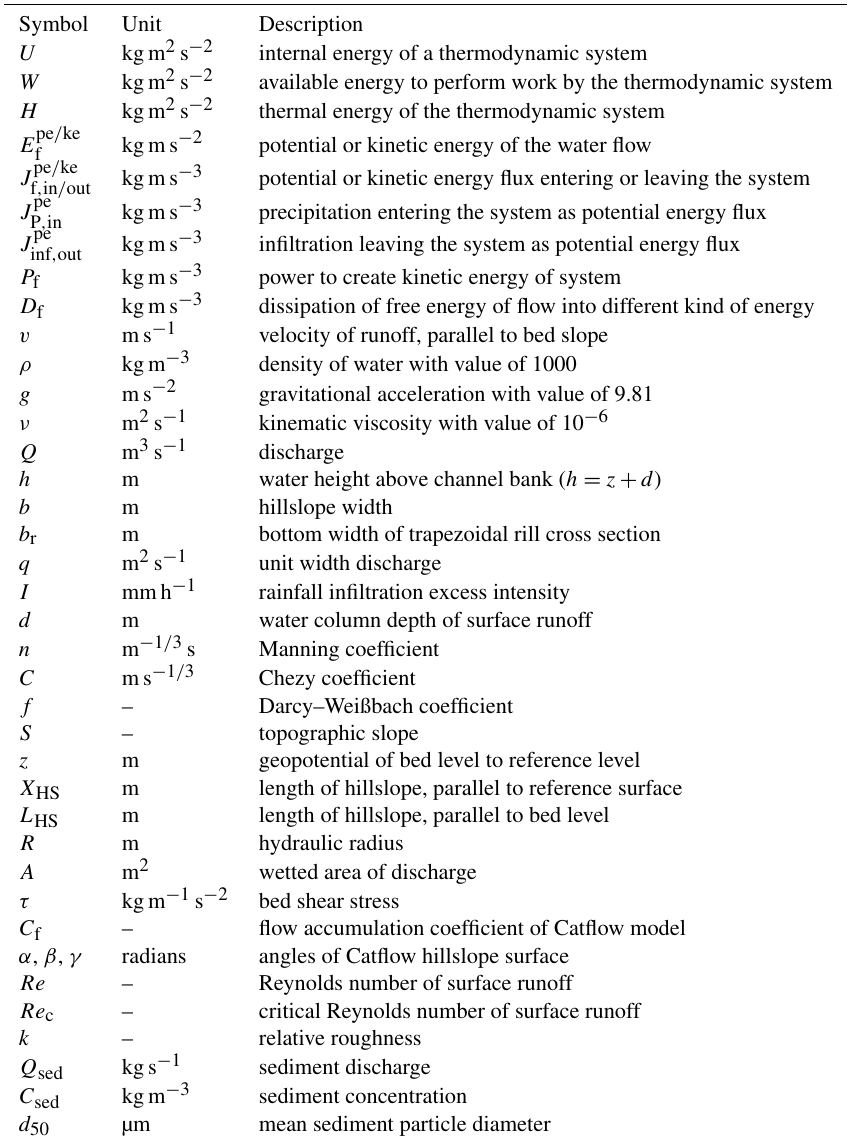
Table 2. Overview of the different symbols used in this